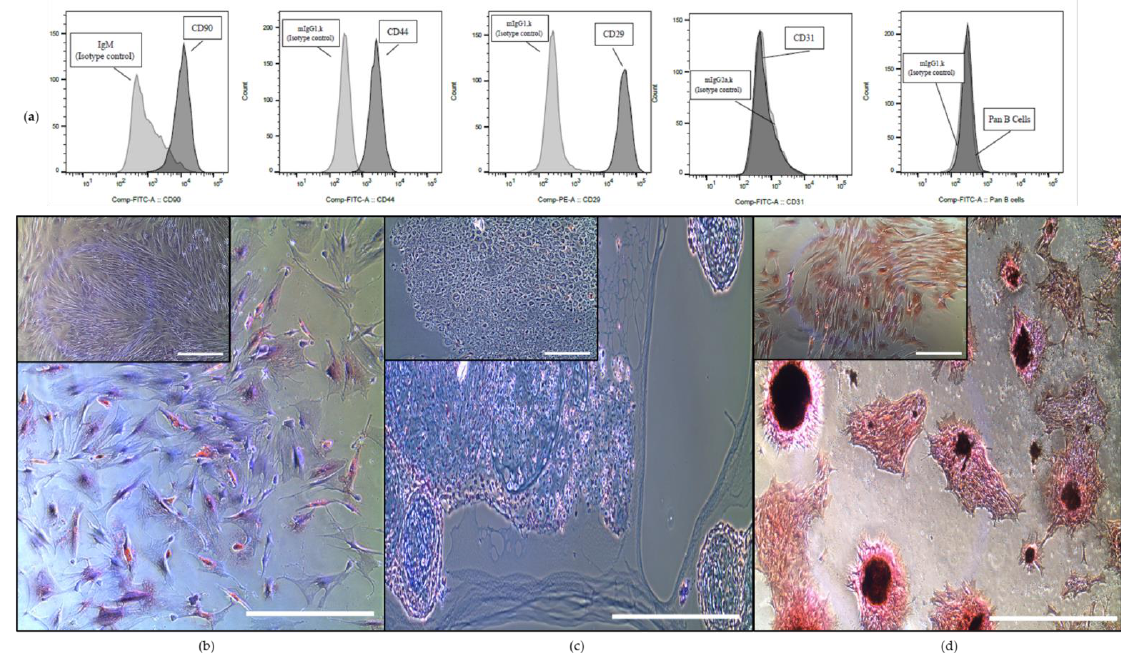
Figure 1. Characterisation of the equine bone-marrow-derived cells showing trilineage differentiation capacity and canonical surface marker expression of equine MSCs. ( a ) Bone-marrow-derived cells were stained with the indicated cell surface antigens (dark grey plots) or Immunoglobulin (Ig) isotype controls (light grey plots) and analysed by flow cytometry (one representative FT-FC experiment is shown). Cells stained positive for CD90, CD44 and CD29 and negative for CD31 and Pan B, as well as IgG isotype controls. Displayed on the x-axis is either Phycoerythrin (PE) or Fluorescein isothio- cyanate (FITC) conjugated to one the previous mentioned antibodies. ( b – d ) Bone-marrow-derived cells showing trilineage differentiation into the adipogenic (( b ) stained with Oil red O, scale bar: 400 µ m), chondrogenic (( c ) stained with Alcian blue, scale bar: 400 µ m and 100 µ m for the control) and osteogenic (( d ) stained with von Kossa stain, scale bar: 400 µ m) lineage. The corresponding controls (cells grown in expansion medium) are shown in the insert in the top left corner of each